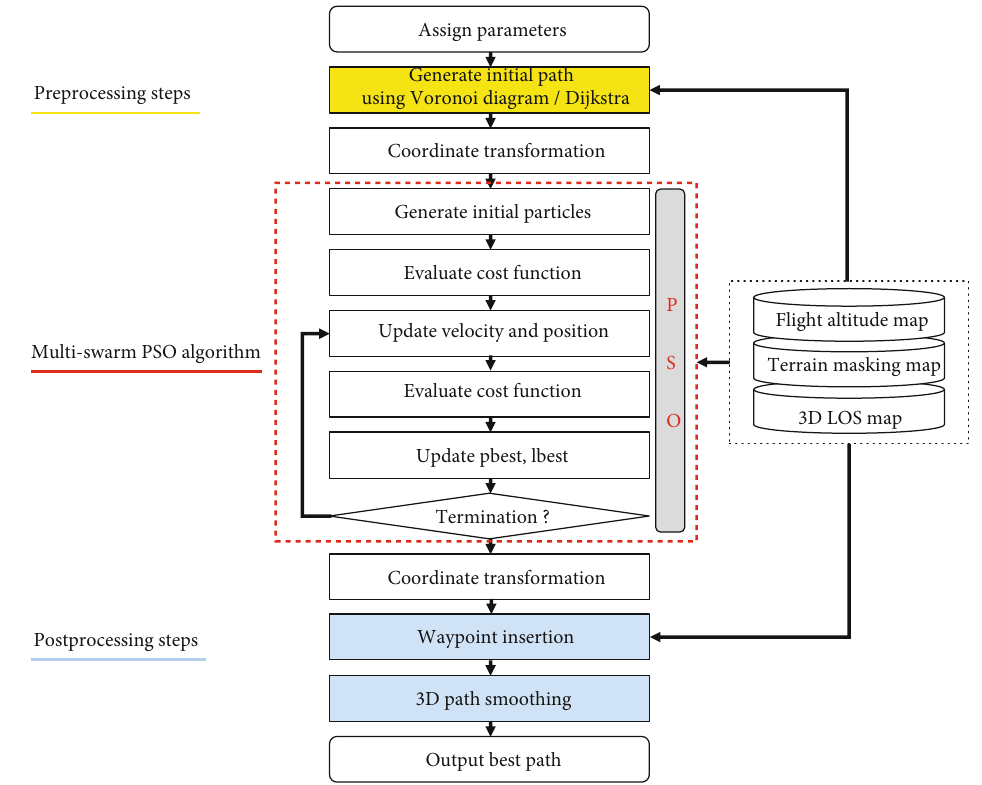
Figure 8: Flowchart of the proposed PSO